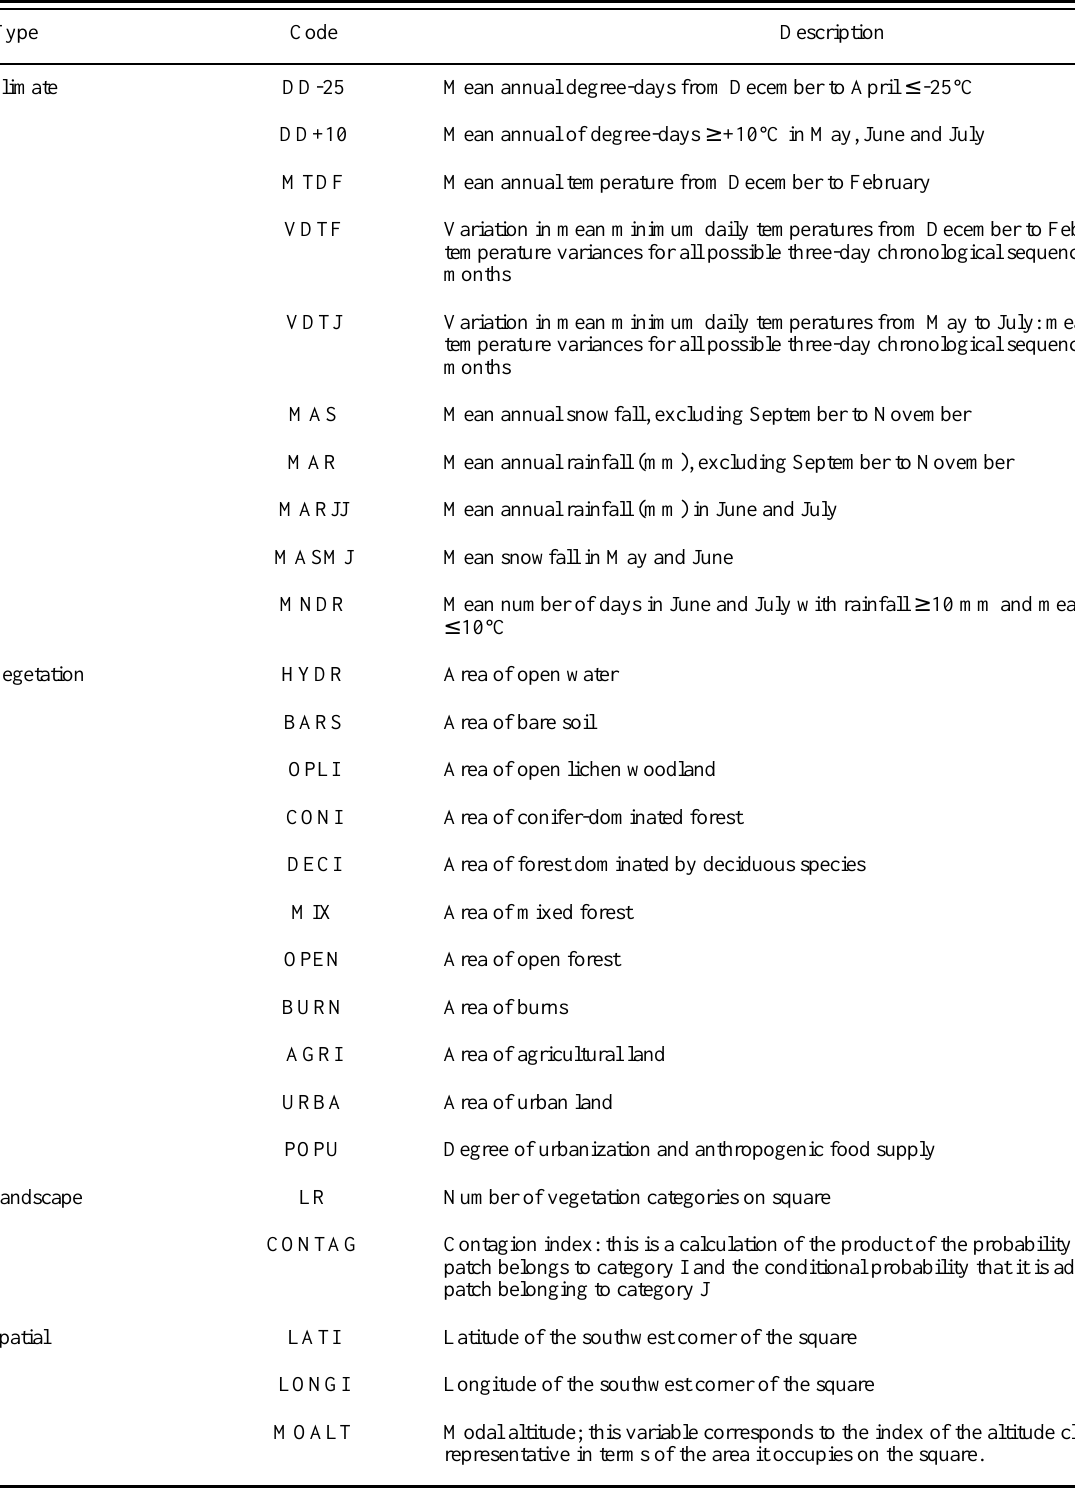
Table 3. Independent variables used in the canonical correlation